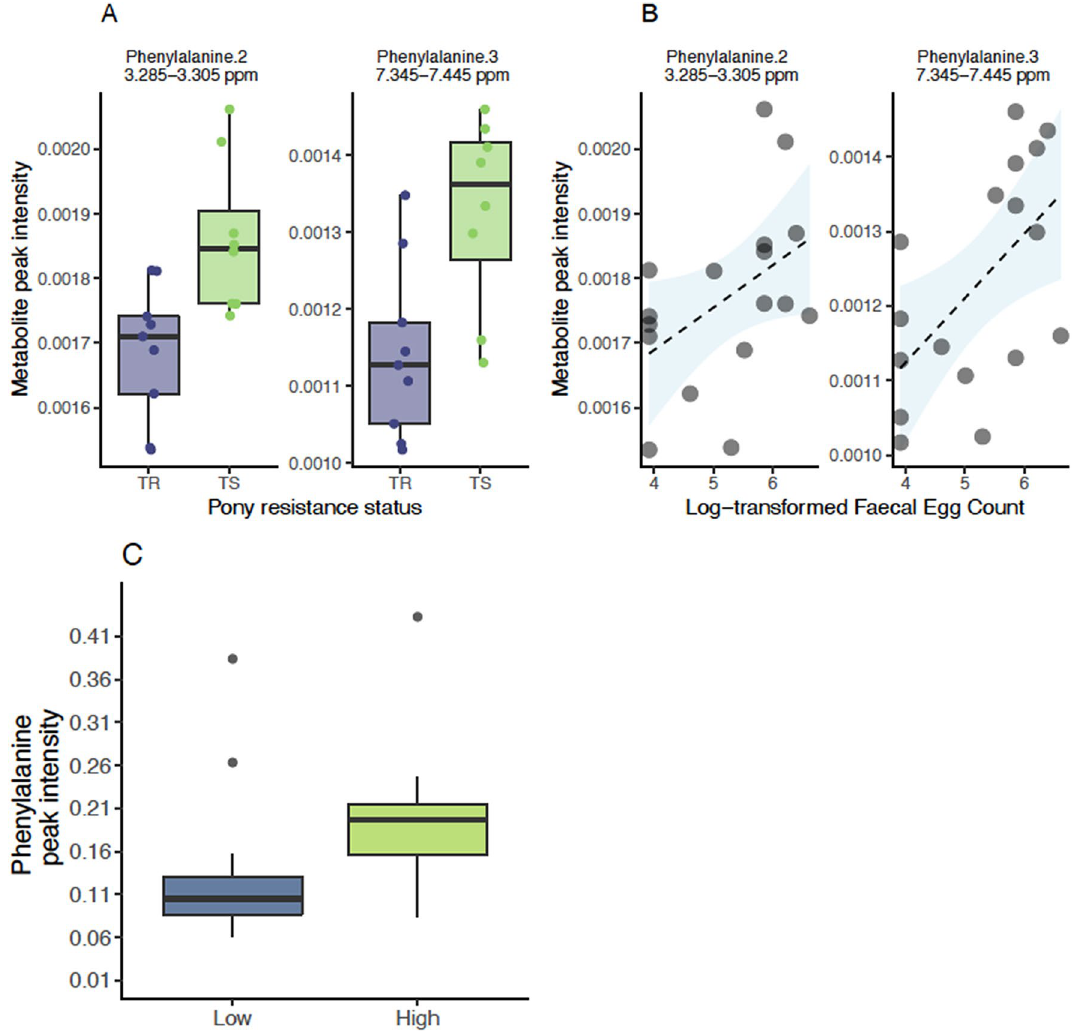
Figure 3. Differential metabolites between infected resistant and susceptible ponies (day 132). Panel ( A ) shows metabolite signal intensity distribution in each pony susceptibility group (purple: resistant, TR; green: susceptible, TS) at day 132. Panel ( B ) shows the relationship between these metabolite signal intensities (Y-axis) at day 0, and matching log-transformed faecal egg count (X-axis) at day 132. Panel ( C ) describes observed phenylalanine levels in the faecal matter of an independent cohort of British horses with low or high and the plasma levels of serine and essential amino acids such as phenylalanine, lysine and tryptophan (Fig. 4, Supplementary Figs. 3 and 4). This underscores the association between phenylalanine and FEC (Fig. 3B, C). Additional features included higher monocyte counts (1.178 ± 0.23 and 1.038 ± 0.24 million cells/mm 3 in TR and TS ponies on average) and higher levels of plasma alkaline phosphatase (ALP; 5.39 ± 0.15 and 5.25 ± 0.12 Units/L) in TR ponies (Fig. 4). However, these parameters displayed least covariation with other parameters (Fig. 4). Analysis for KEGG pathway enrichment of metabolite signals found significant over-representation of Ami- noacyl-tRNA biosynthesis (FDR = 1.1 × 10 −4 ) underpinned by the presence of alanine, lysine, phenylalanine, serine, and tryptophan (Supplementary Table 2). Of note, variations in alanine and phenylalanine plasma levels were similar to what was previously reported for dengue fever 43 , another—yet viral—infectious process (Sup- plementary Table 2). The most significant enrichment was defined by the Blautia , Coprococcus and Ruminococcus association found in forms of pediatric Crohn’s disease 44 (FDR = 2.5 × 10 −3 ). Two other significant enrichments included infection-mediated perturbations associated with the HIV-1 virus in humans (underpinned by Anaer- ovibrio and Clostridium genera, FDR = 1.12 × 10 −4 ) or with murine model of Plasmodium infection (underpinned by Anaeroplasma and Clostridium , FDR = 0.05). To validate the association of the most discriminant blood and bacterial features with FEC, we used either a previously published horse data set 35 for bacterial count, or additional blood samples taken from 25 strongylid infected ponies in 2020 (Fig. 5). Out of the five most discriminating bacterial genera identified by our sGCC- DA approach under infection at day 132, Prevotella (FDR = 0.19; nominal P value = 0.04) also showed significant differences in their mean abundances between Peachey et al.’s horses with low or higher FEC (Fig. 5). Monocyte